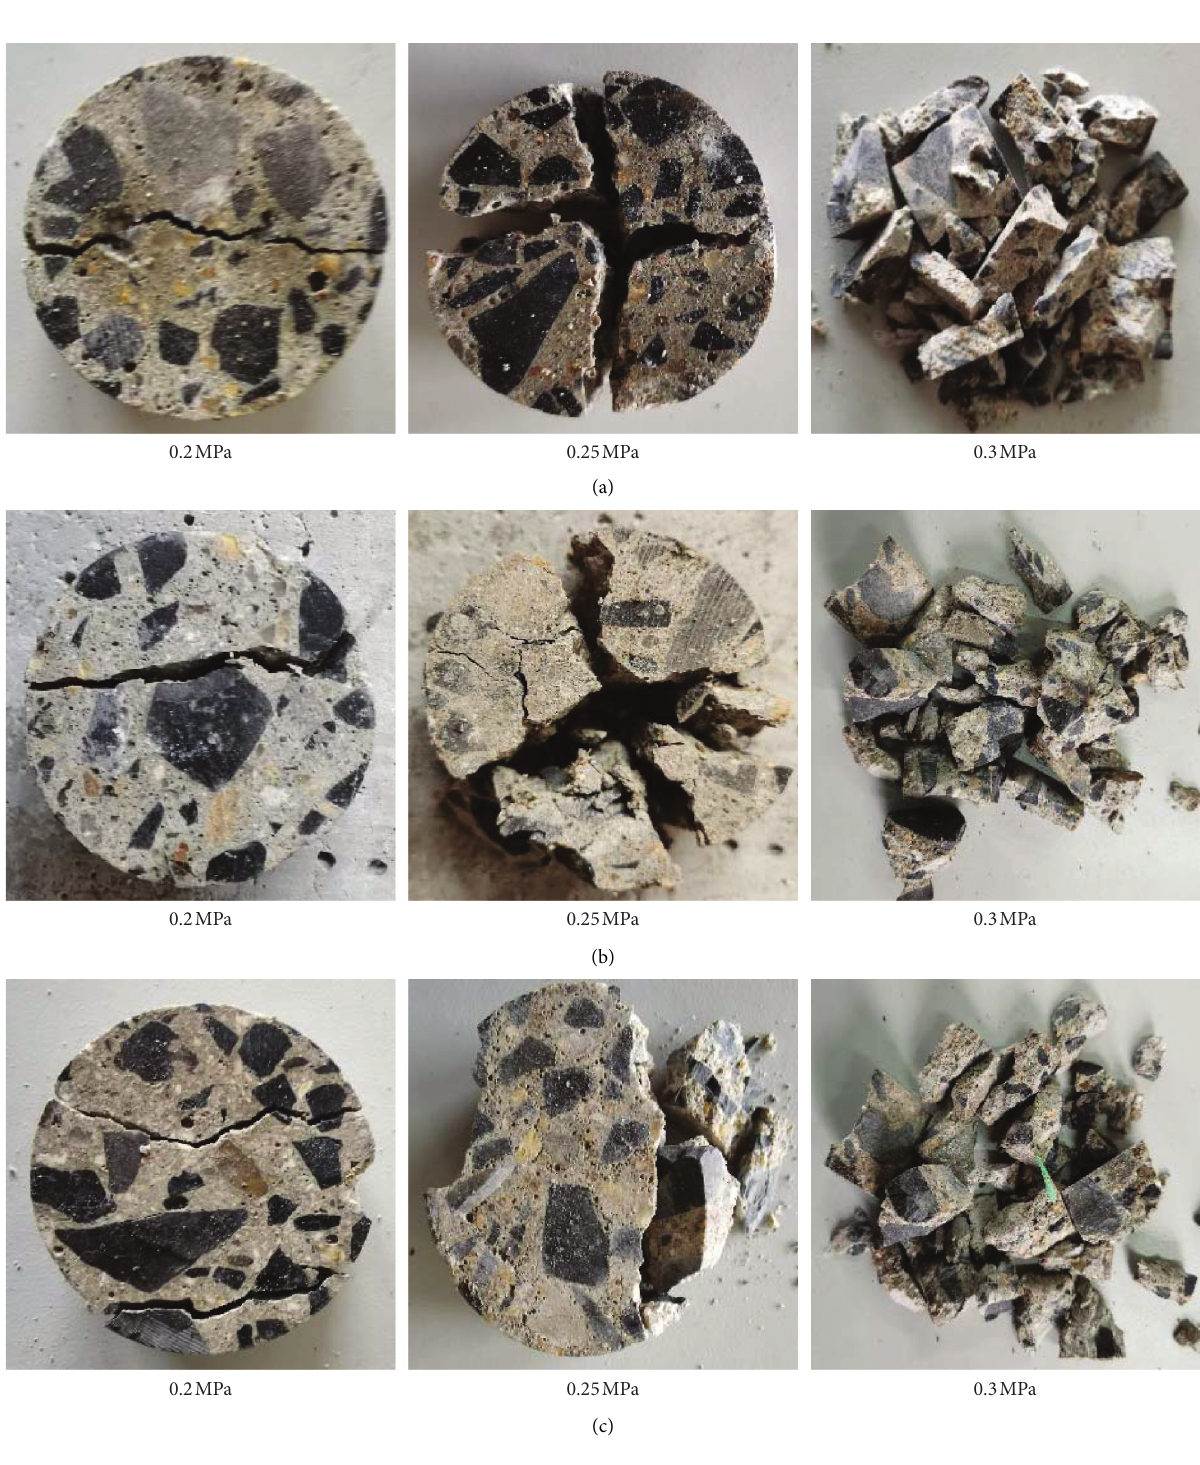
Figure 3: Failure modes of the concrete specimen under different impact strengths: (a) NAC, (b) RAC100, and (c) SRAC100. Table 7: SHPB test results of concrete